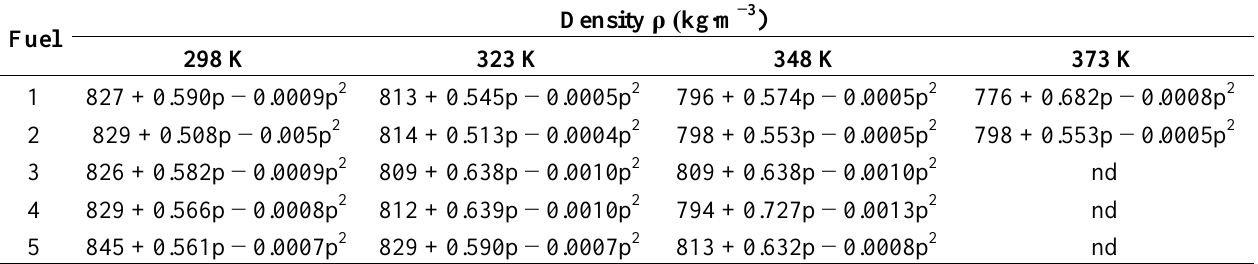
Table 4. Density correlations with pressure for Fuels 1 to